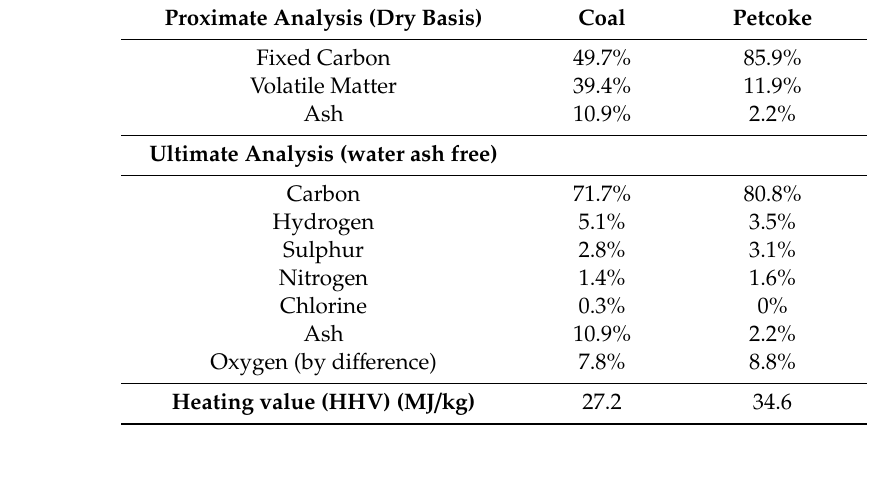
Table 1. Composition of coal and petcoke.